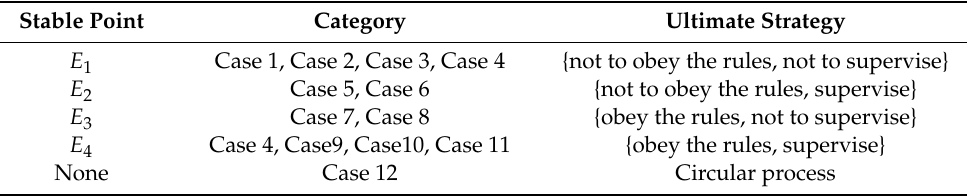
Table 11. Category of cases based on stable